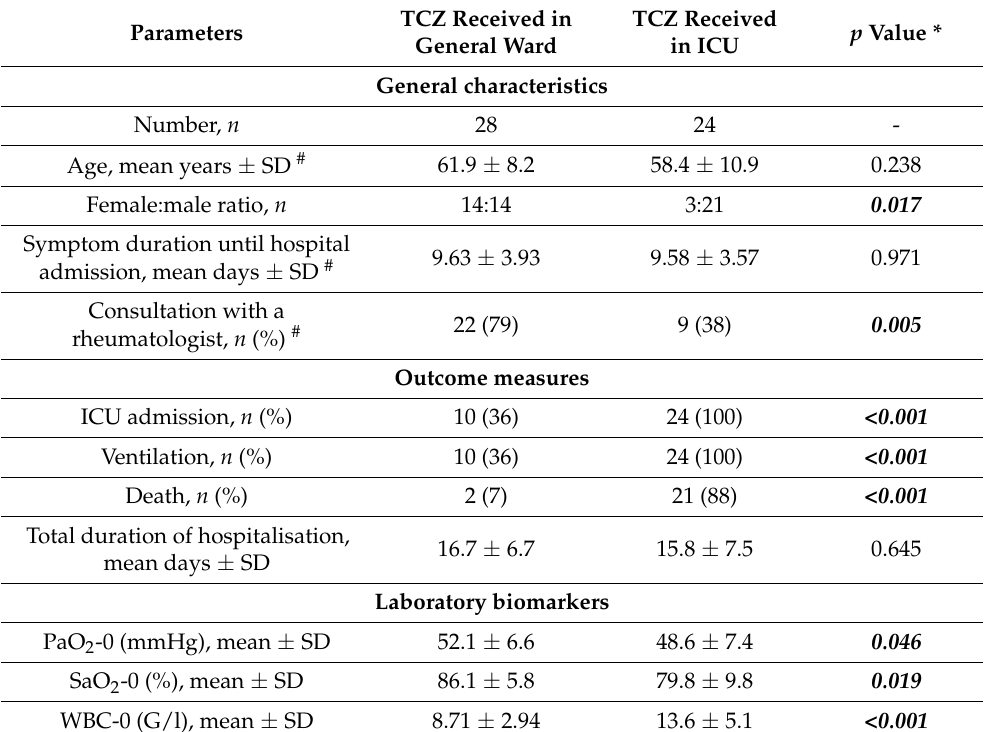
Table 2. Comparison of TCZ-treated patients receiving TCZ in the general ward versus ICU.